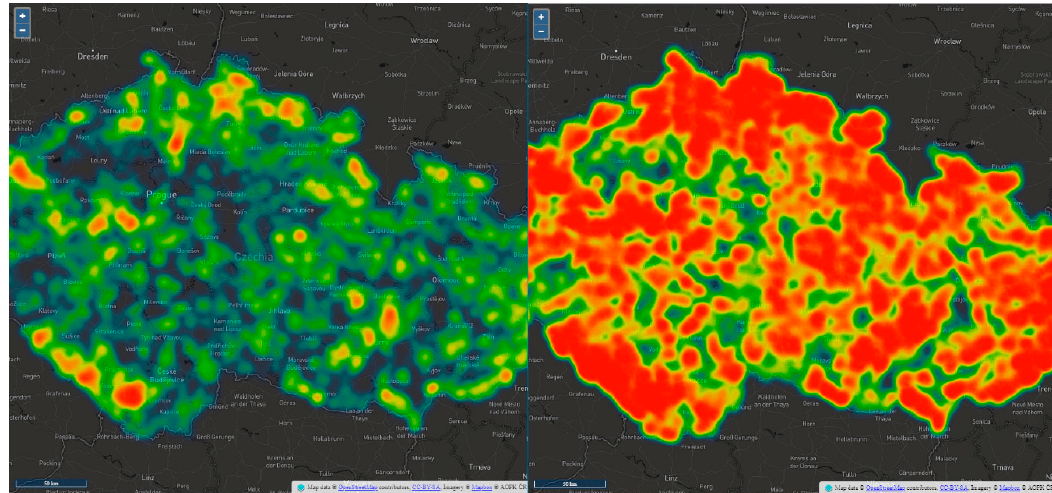
Figure 9. Map output of OpenLayers heatmap—testing on 10,000 and 50,000 of points.